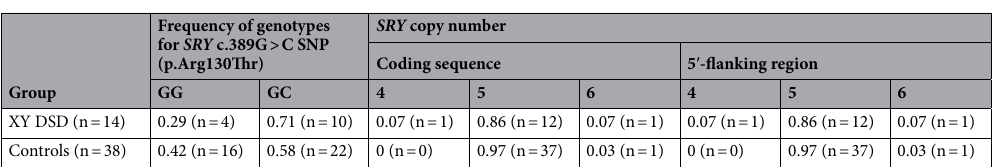
Table 2. Molecular analysis of the SRY gene in XY DSD and control cats. Genotype frequencies for a known c.389G > C SNP and SRY copy